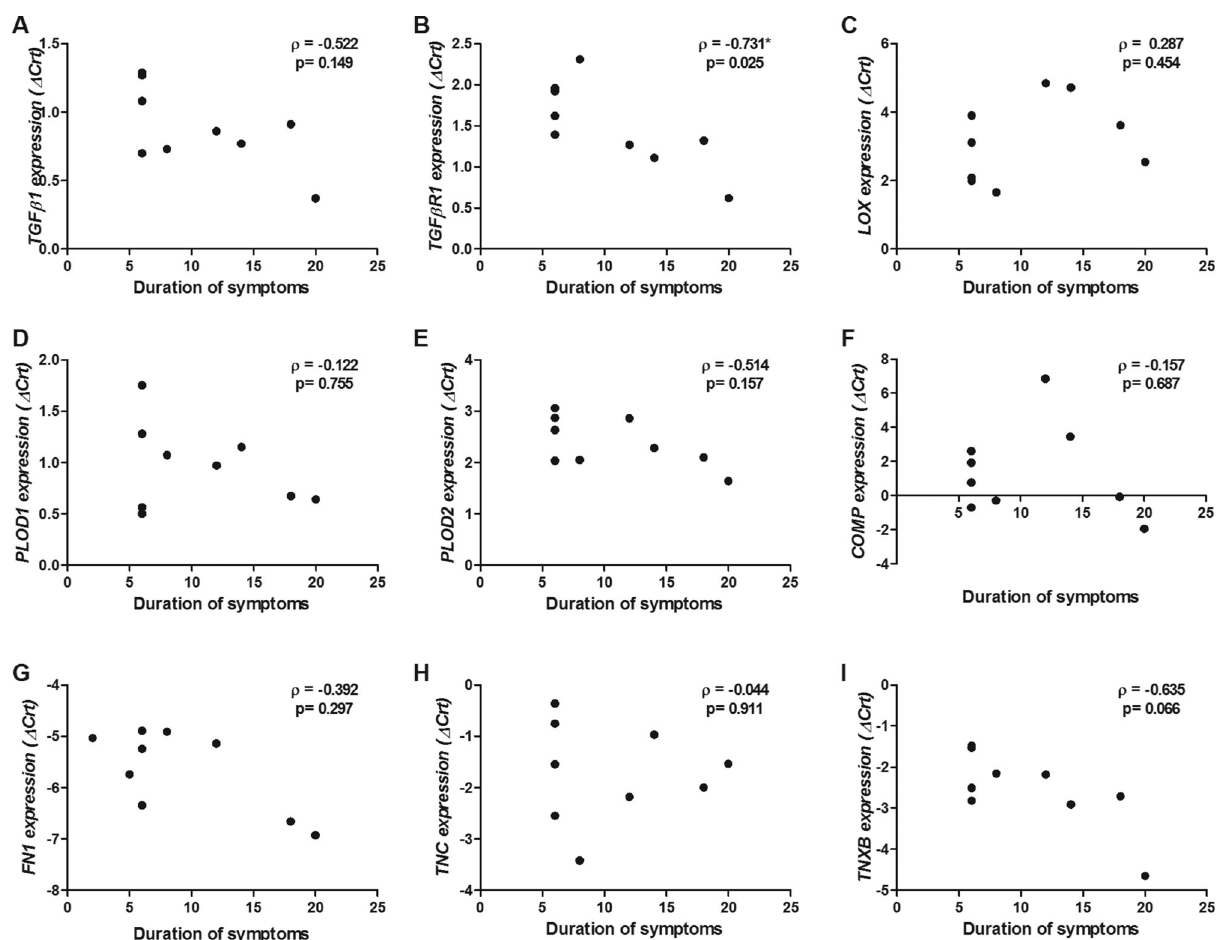
Figure 2 - Correlation between gene expression and duration of adhesive capsulitis (months). A) TGF b 1 ; B) TGF b R1 ; C) LOX ; D) PLOD1 ; E) PLOD2 ; F) COMP ; G) FN1 ; H) TNC ; and I) TNXB. r : Spearman correlation coefficient ("rho"). * Significant correlation ( p o 0.05). A lower delta cycle threshold value ( D Crt) indicates higher